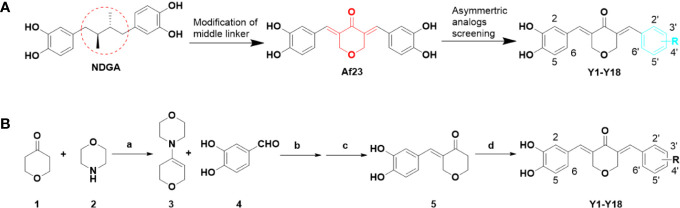
Design of novel asymmetric NDGA analogues as potential FGFR1 inhibitors (A) and the general synthesis routes of Y1–Y18 (B). Reagents and conditions: (a) p-TSA, cyclohexane, reflux, 50%; (b) EtOH, 90°C, 30%; (c) 10% HCl solution, rt, 50%; (d) differently aldehydes, HCl gas, EtOH, 50–70°C, 10–70%.